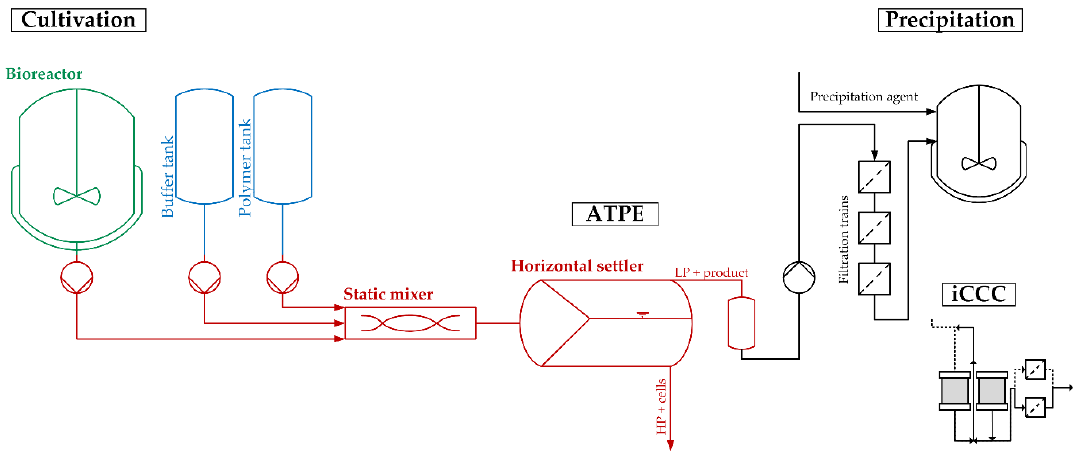
Figure 2. Process segment as discussed in the risk assessment. LP: Light phase. HP: Heavy phase. iCCC: integrated counter-current chromatography.